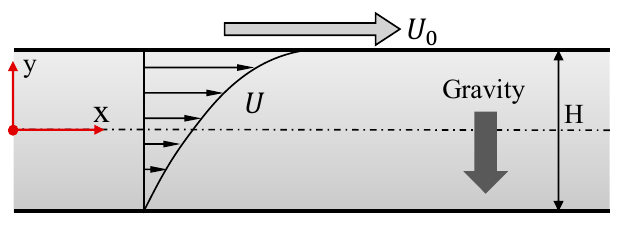
Figure 1. Schematic of the flow.